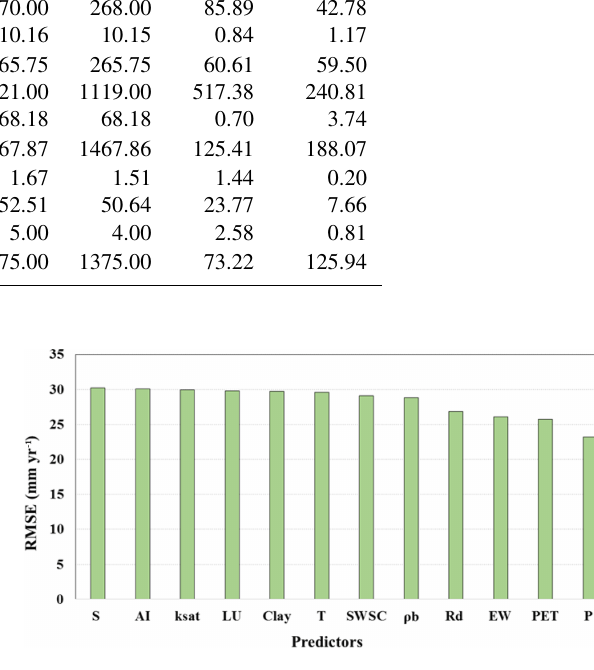
Figure 3. Model fit performance criteria for single predictor regres-